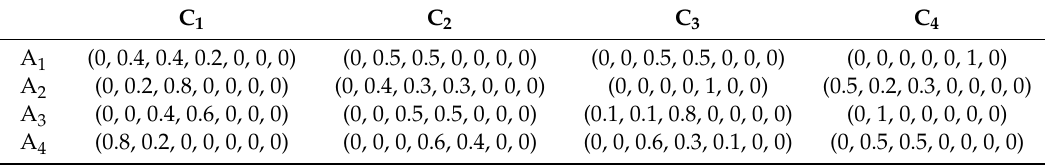
Table 6. Possibility distribution hesitant fuzzy linguistic decision matrix by expert E 3